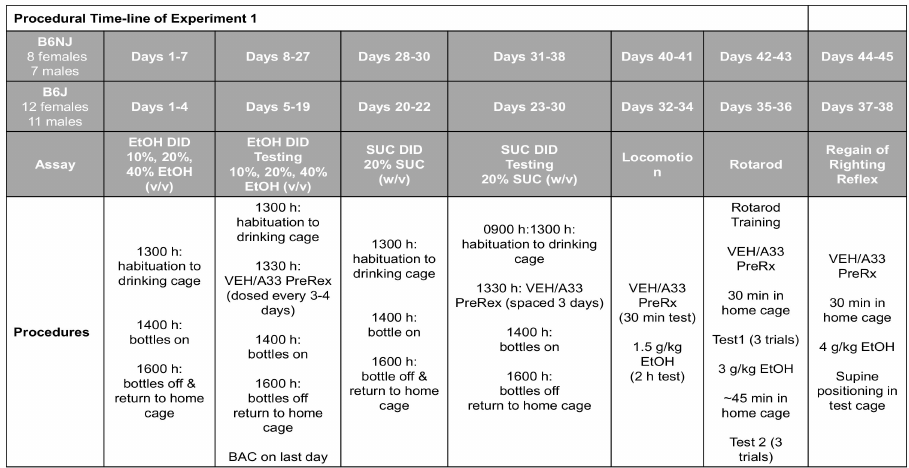
Figure 1. Summary of the procedural timeline for Experiment 1, which employed a within-subjects design to determine ( 1 ) the dose–response function for A33 effects upon alcohol (EtOH) intake under 3-bottle drinking-in-the-dark (DID) procedures; ( 2 ) the effect of 1.0 g/kg A33 on sucrose (SUC) intake under DID procedures; and ( 3 ) the effect of 1.0 mg/kg A33 tests for spontaneous and alcohol-induced changes in locomotor activity, rotarod performance and then alcohol-induced sedation using the regain of righting reflex